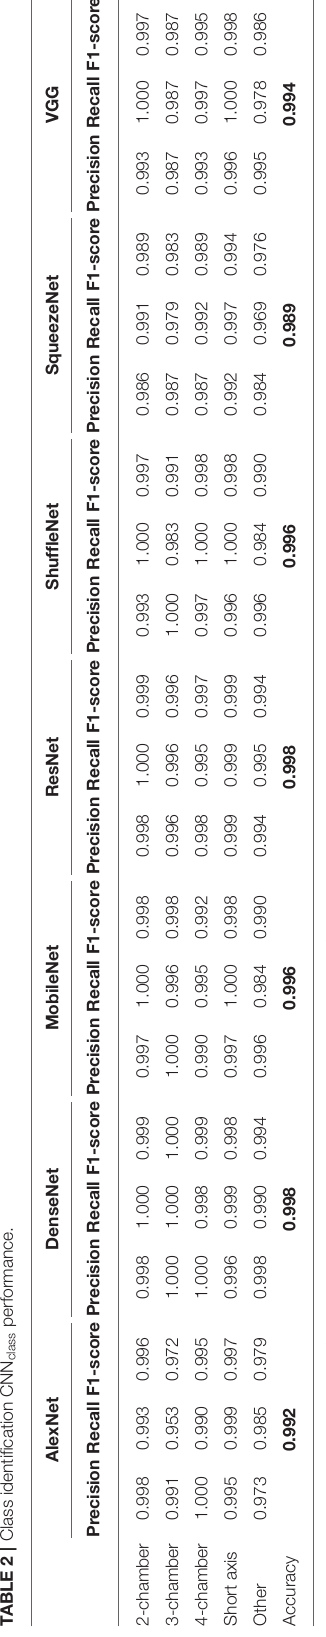
TABLE 1 | Population